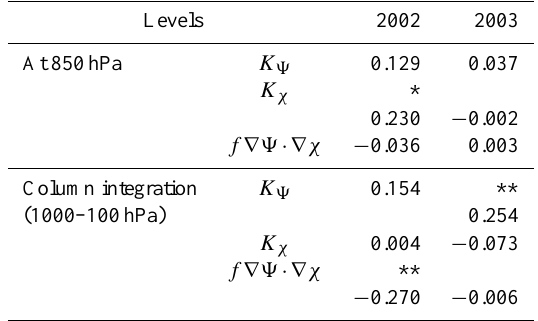
Table 1. Correlation coefficient between rainfall and K 9 , K χ , f ∇ 9 ·∇ χ for 2002 and 2003. * Significant at 0.05 level (95%), ** significant at 0.01 level (99%)